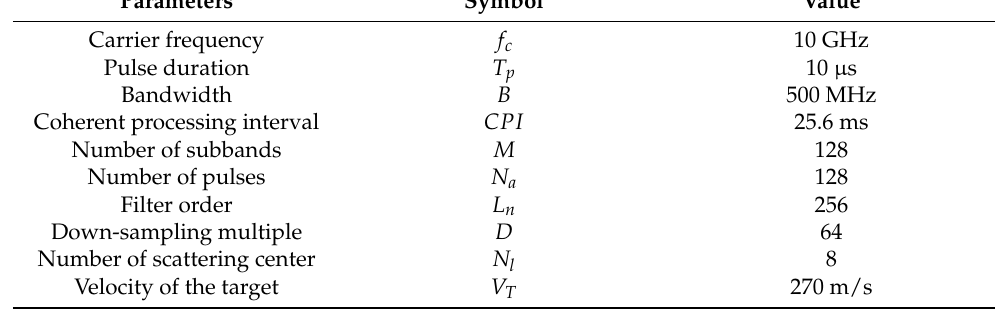
Table 2. Simulation experiment parameters.